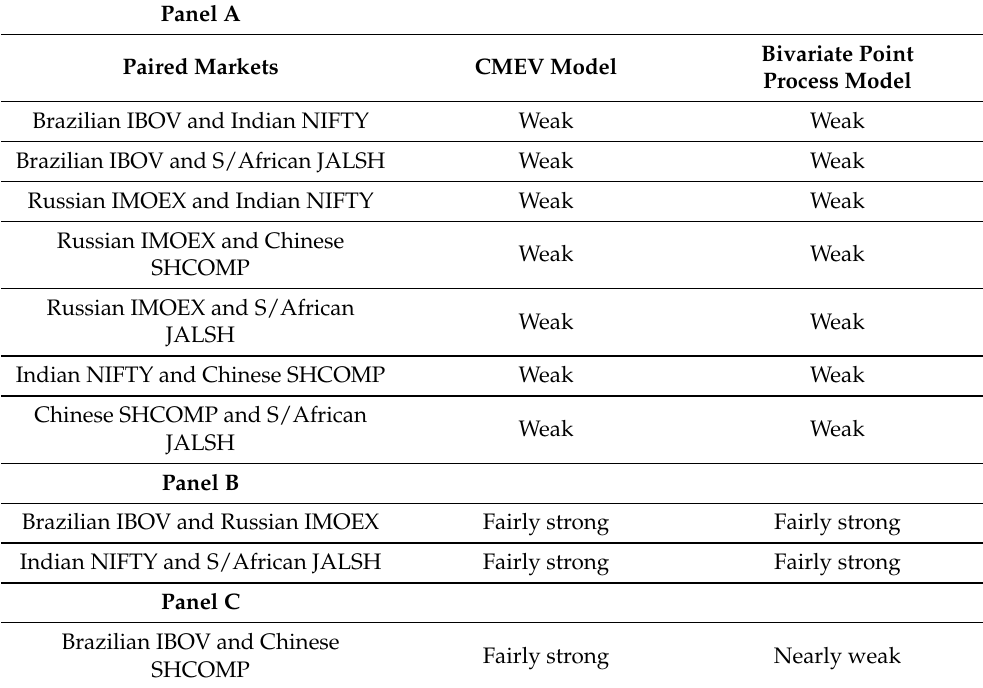
Bivariate Point Process